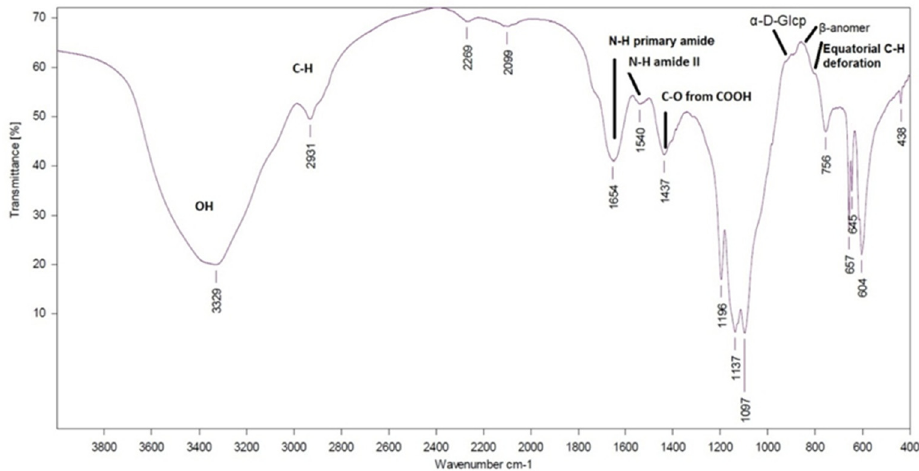
Figure 1. FTIR spectrum of exopolysacchirides (EPS) from T. versicolor NBIMCC 8939 .